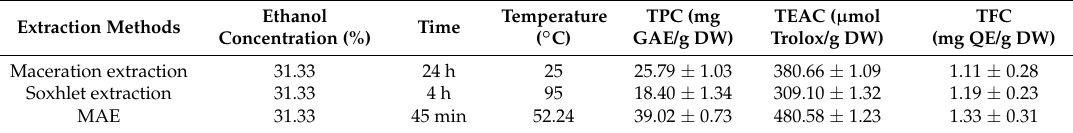
Table 3. The comparison of microwave-assisted extraction with maceration and Soxhlet extraction. Extraction